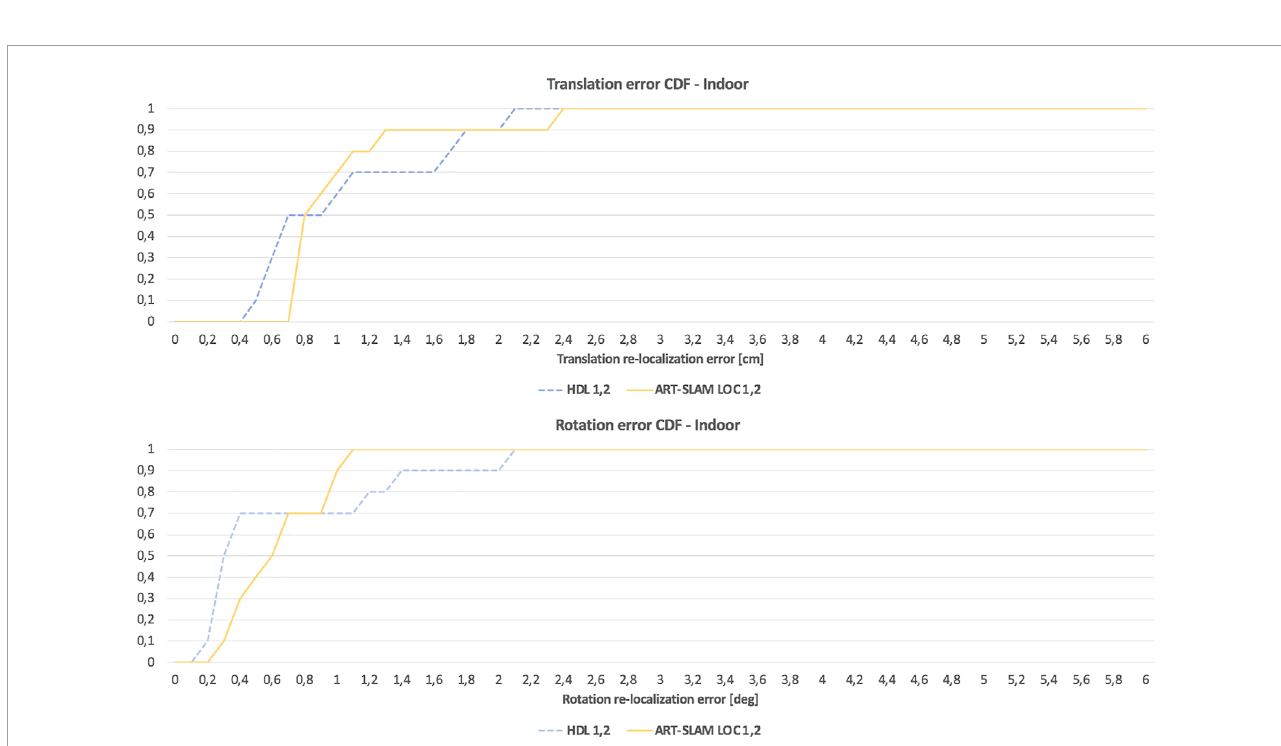
FIGURE 5 CDF of the re-localization errors of the indoor experiment, consisting of both translational and rotational components, using HDL Koide et al. (2019) and ART-SLAM Frosi and Matteucci (2022).